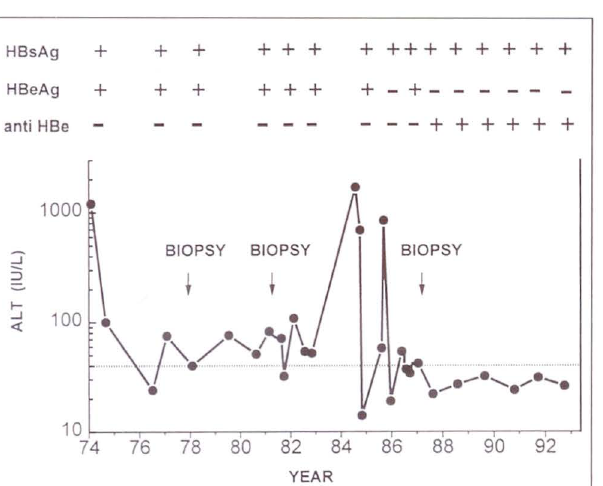
Figure 1) The natural history of chronic hepatitis B: a repre sentative example. A 34-year-old man developed acute type B hepatitis in 197 4 and became a chronic canier of the hepatitis B virus. From 1974 to 1985. there was evidence of active viral replication (positive hepatitis B e antigen [HBeAg] in serum and positive hepatitis B core antigen on liver biopsy). A first biopsy in 1977 showed chronic hepatitis and a second one in 1981 chronic hepatitis withfibrosis. In 1984-85, a sharp rise in senun alanine aminotransferase (ALT) was followed by a spontaneous serocon version from HBeAg-positive to anti-HBe-positive with